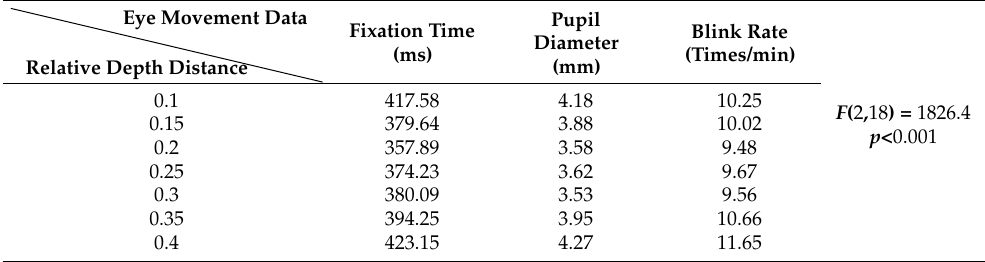
Table 18. Depth distance of different relative positions of the information display layer, the average value of eye movement data for completing the task.